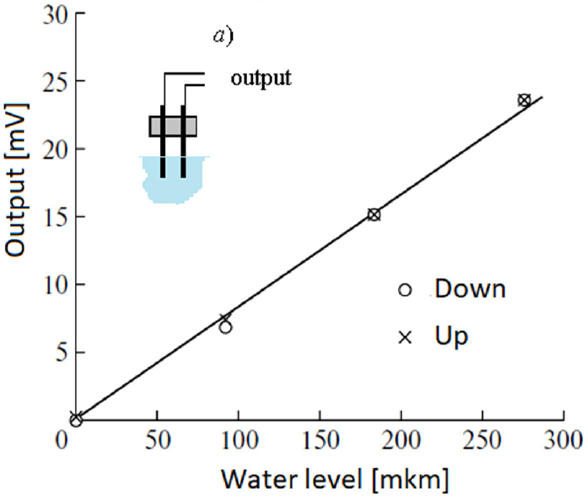
Figure 3. Т ypical calibration curve. (a) Schematic diagram of the resistive sensor. Resistive sensors, which were located at various distances from the wave generator, measured the displacement of the free surface of the water at the time intervals ξ ( t ). It is now possible to draw wave x-t diagrams for each experiment and to determine: the velocity of waves and the amplitude factors of wave reflection R = (cid:113) W t ≈ A t transition T = during the interaction with the underwater barriers. Here W ; W r W A and W t are the total energy of the incident, reflected, and transmitted waves, respectively. A r and A t are averaged amplitudes of reflected and transmitted